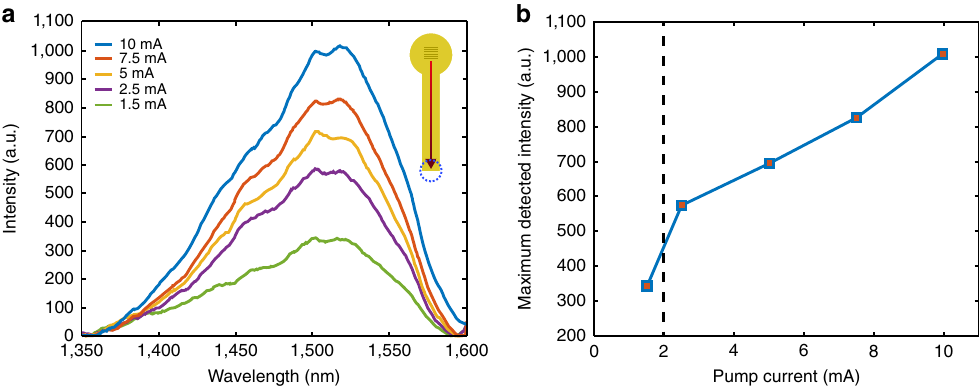
Figure 5 | SPP frequency conversion on a VCSEL. ( a ) SPP scattering spectra for different VCSEL driving currents, measured from the dielectric-loaded SPP (DLSPP) waveguide doped with PbS quantum dots with the peak emission wavelength of B 1,500nm. The inset shows a schematic with the collection area marked by a blue circle, where SPPs out-couple due to scattering at the end of the DLSPP waveguide. ( b ) The dependence of the intensity at 1,515nm on the VCSEL driving current. The threshold current for this VCSEL was about 2mA, as shown by the dashed line. a.u., arbitrary units.